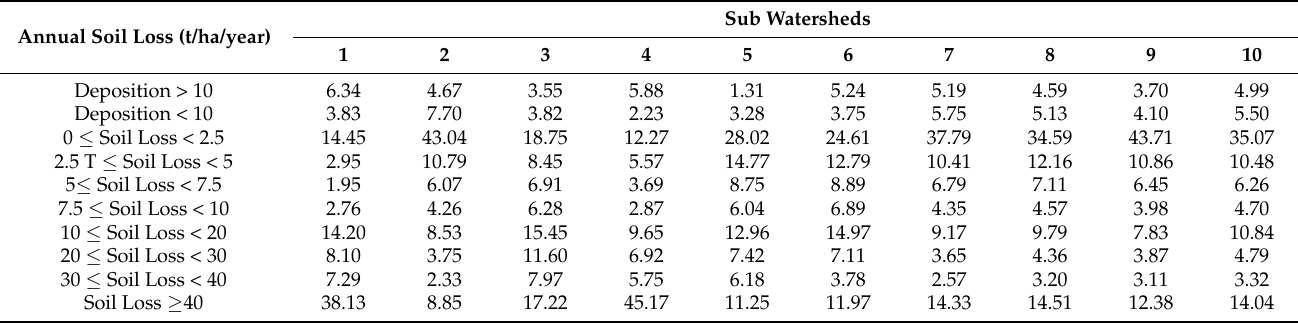
Table 5. Onsite GeoWEPP model simulation results for the 10 sub-watersheds and their percentage distribution by soil loss rates.